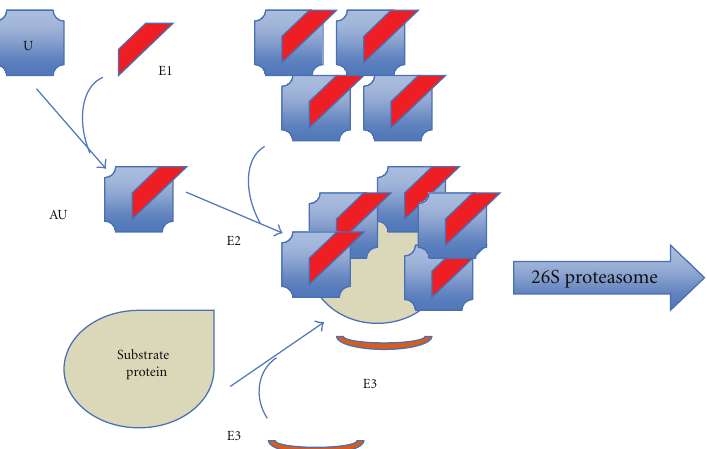
Figure 2: Ubiquitin-proteasome system. U: ubiquitin, AU: activated ubiquitin, E1: ubiquitin-activating enzyme, E2: ubiquitin-conjugating enzyme, E3: ubiquitin